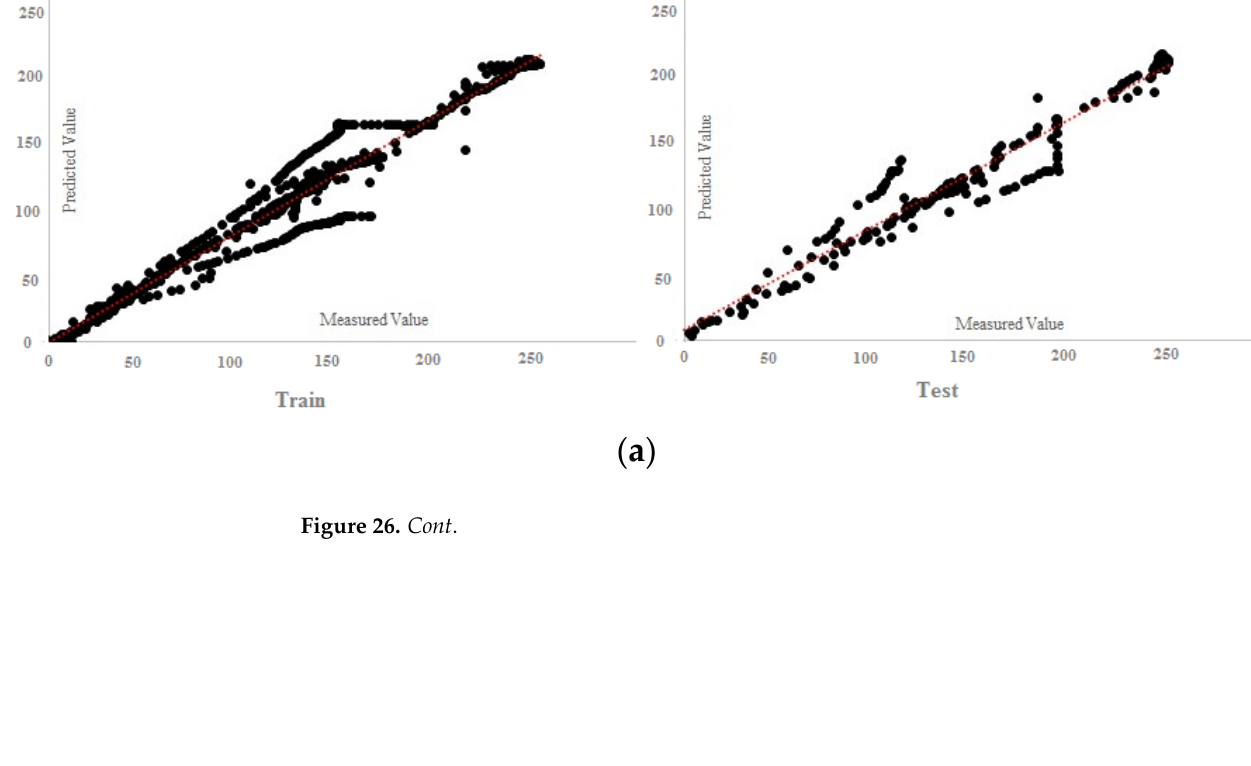
Figure 25. Tolerance diagram with respect to the MPF (four inputs) prediction: ( a ) test phase, ( b ) train phase.